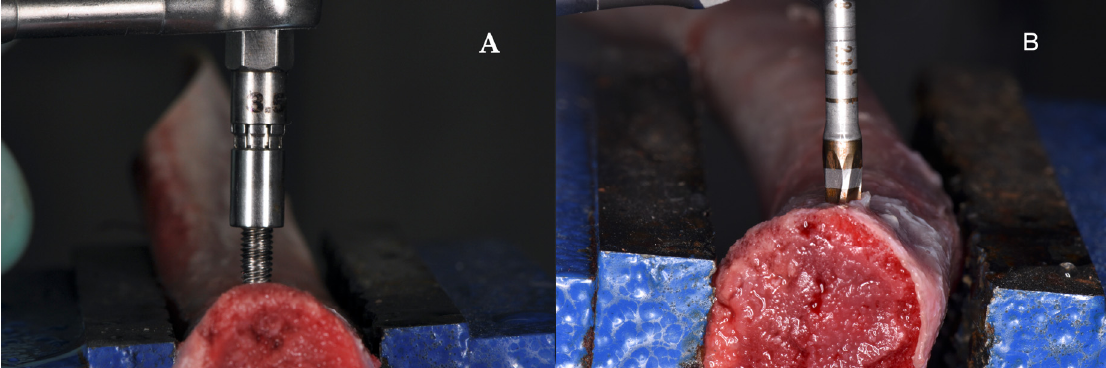
Figure 1. Surgical protocols performed in cancellous bone: Bone compaction implant site preparation ( A ); osseodensification implant site preparation ( B ).